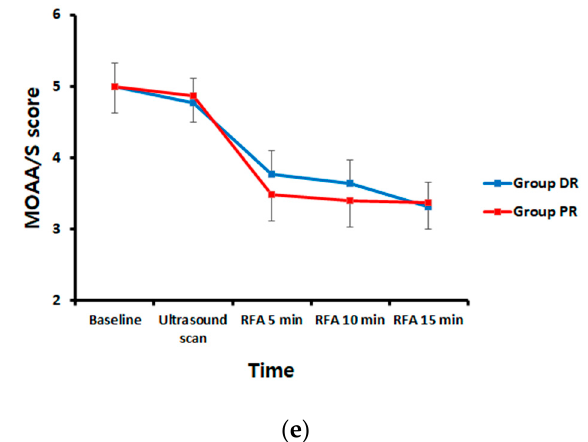
Figure 5. The trends over time of ( a ) end-tidal carbon dioxide (EtCO 2 ), ( b ) heart rate (HR), ( c ) respiratory rate (RR), ( d ) mean blood pressure (MBP), and ( e ) modified observer’s assessment of alertness/sedation scale (MOAA/S) score during sedation. The extent in increase of the EtCO 2 level in the PR group was larger than that of the DR group over time (DR group, p < 0.001 and ß = 2.860 vs. PR group, p < 0.001 and ß = 3.780). The HR decreased over time in the DR group ( p = 0.002, ß = − 1.650), and showed no significant changes over time in the PR group ( p = 0.139, ß = 0.670). In both groups, RR decreased over time ( p = 0.231 ß = 0.350). There was no significant difference in the MBP of the two groups over time ( p = 0.906, ß = 0.12). The MOAA/S score was comparable over time ( p = 0.649, ß = 0.02). DR, dexmedetomidine-remifentanil; PR, propofol-remifentanil; RFA, radiofrequency